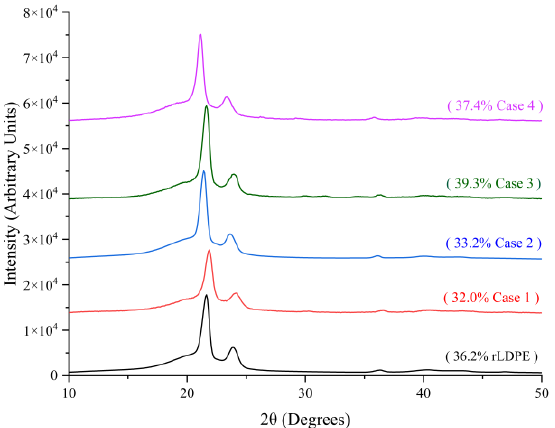
Figure 8. XRD curves of developed biocomposites at 20% filler content compared to neat rLDPE. Table 2. Summary of degree of crystallinity of the developed biocomposites compared to neat rLDPE. Filler Content